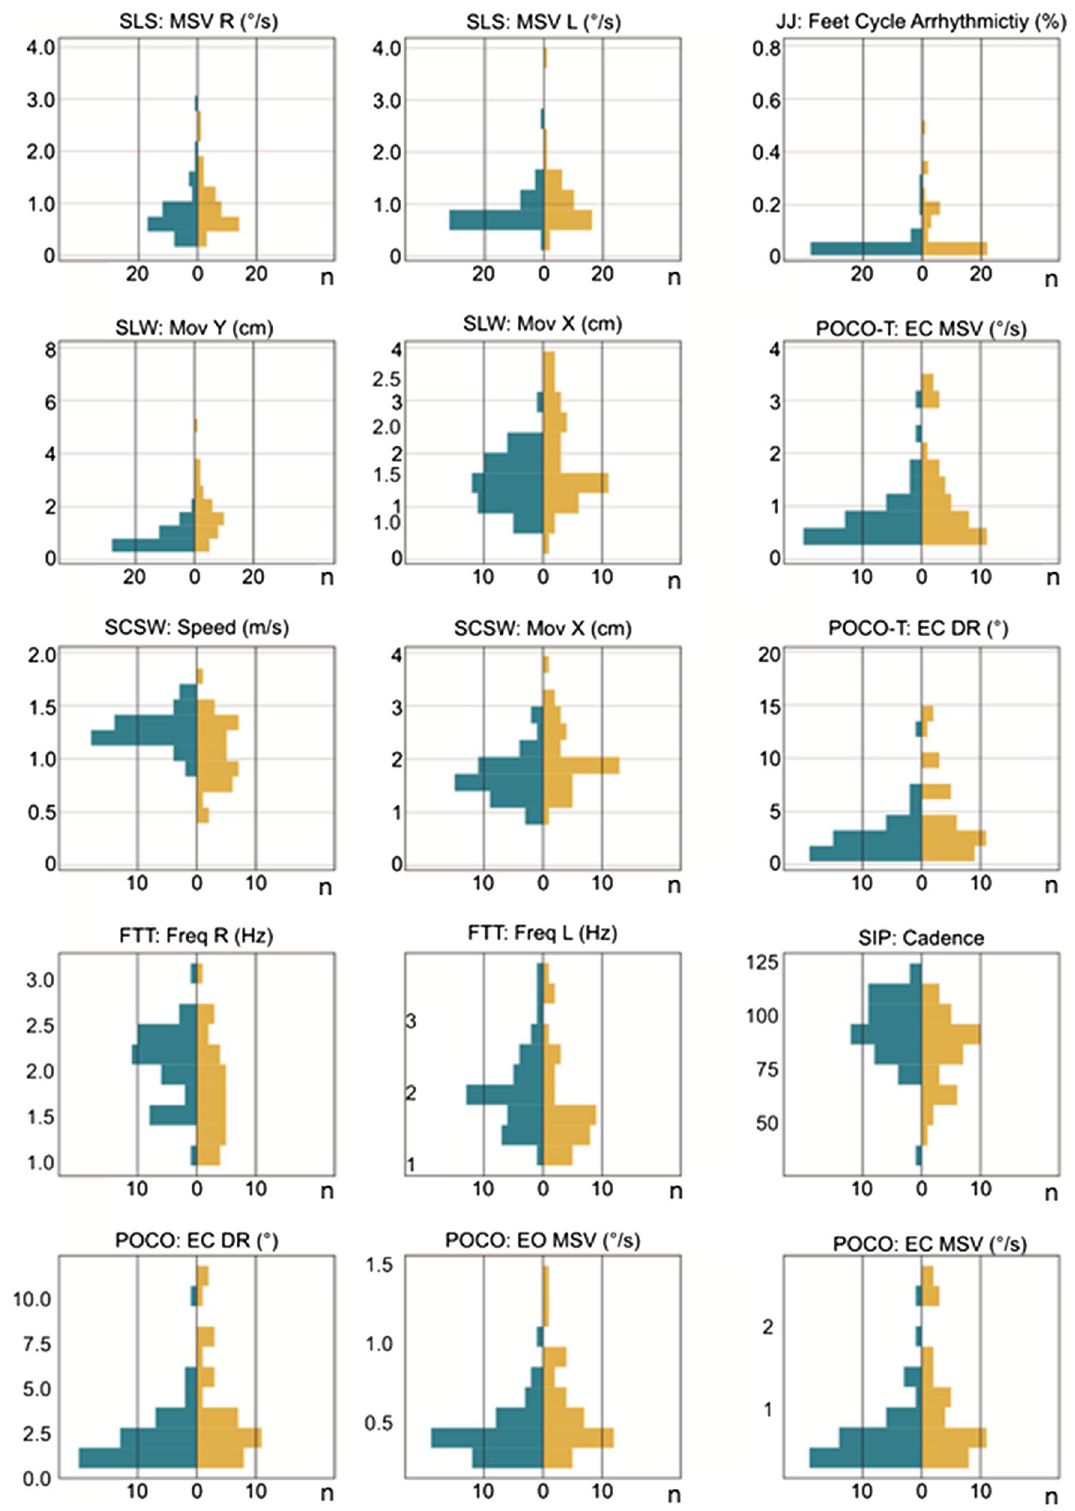
Figure 2. Butterfly histograms for selected quantitative measures from VPC motor assessment (single leg stance, jumping jack arrhythmicity, line walk, stance feet closed, walk in comfortable speed and finger tap test). Performance in ASD/HC are depicted on the right (blue)/left (orange) from midline. HC = healthy controls, ASD = autism spectrum disorder, EC = eyes closed EO = eyes open, DR = deflection range in 3D, MSV = mean sway velocity in 3D, Mov X = movement deviation in mediolateral direction, Mov Y = movement deviation in anteroposterior direction at hip level, R = right, L = left, Hz = Hertz, Freq = frequency, POCO = postural control stance, POCO-T = postural control tandem stance, SLS = single leg stance, SLW = line walk, SCSW = walk at a subjectively comfortable speed, SIP = stepping in place, pSIP = paced stepping in place, JJ = jumping jack, FTT = finger tapping test. For description of movement tasks see Table